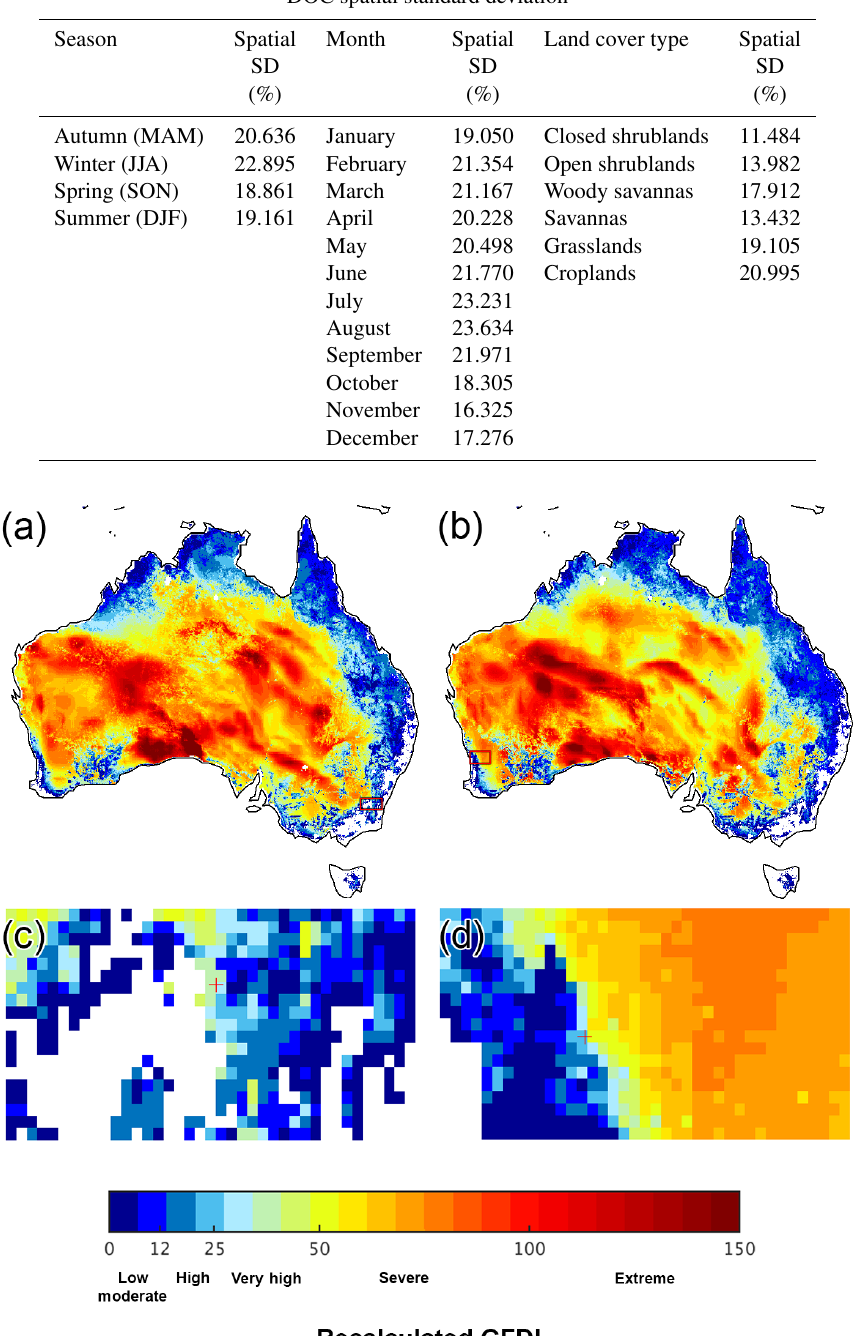
Figure 8. Maximum estimated Grassland Fire Danger Index (GFDI) for the summers (December, January, February) of 2002–2003 (a) and 2009–2010 (b) . Both zoomed areas marked with red bounding boxes for (a) and (b) are shown in (c) and (d) , respectively. The fire locations for Canberra fire (c) and Toodyay fire (d) are marked by red plus signs. Forest areas are masked out in